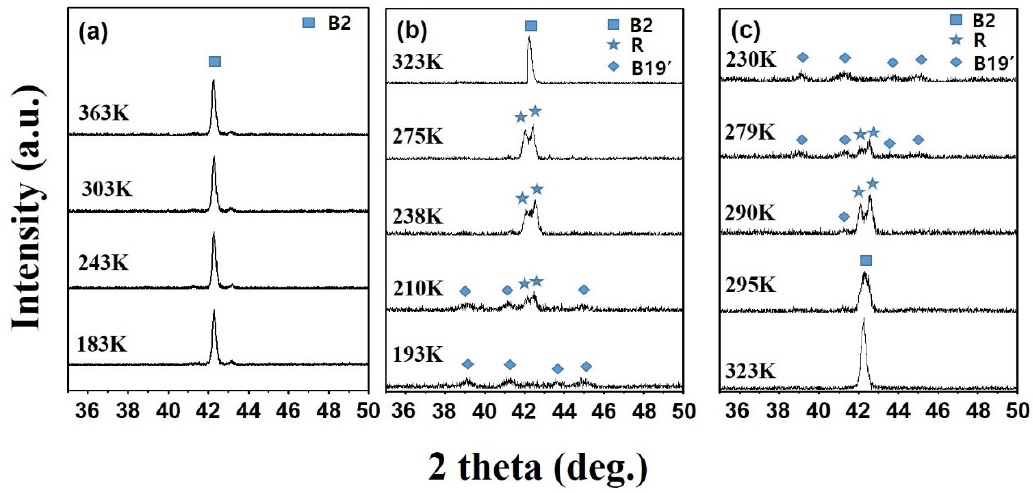
Figure 6. Low temperature XRD results of Ti-49.9Ni (at %) thin film with a substrate temperature of ( a ) 723 K, ( b ) 773 K (cooling,) and ( c ) 773K (heating). (Deposition condition: growth rate (6.29 nm/min), thickness (1.7 μm)).